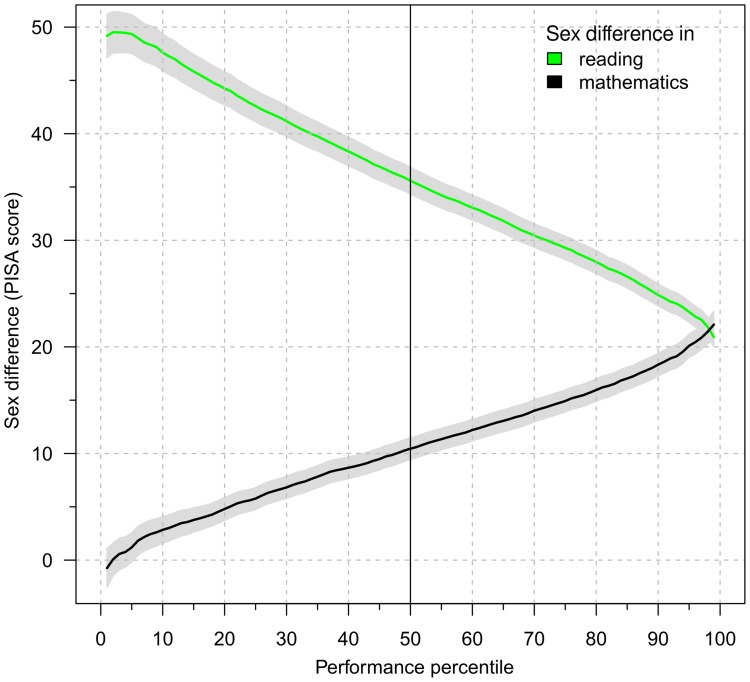
The magnitude of the within-country mathematics and reading sex differences across performance.The two curves represent the magnitude of sex difference in mathematics (black) favoring boys and the sex difference in reading (green) favoring girls in all 33 countries that participated in all four PISA assessments (2000,2003,2006 and 2009). Grey shading indicates ±1 SEM. Within these countries boys at the 50th percentile of the distribution of boys’ scores have a 10 point advantage in mathematics over girls at the 50th percentile of the distribution of girls’ scores. There is no gap for the lowest performing students and a doubling of the average gap for the highest performing students. For students at the 50th percentile, girls reading advantage is about 37 points and increases for lower performing students and decreases for higher performing students. The relation between the two gaps within these countries is the same as found between countries (Figure 2). For percentiles with a small mathematics gap, the sex difference in reading is large. The larger the sex difference in mathematics within these countries, the smaller the reading gap.